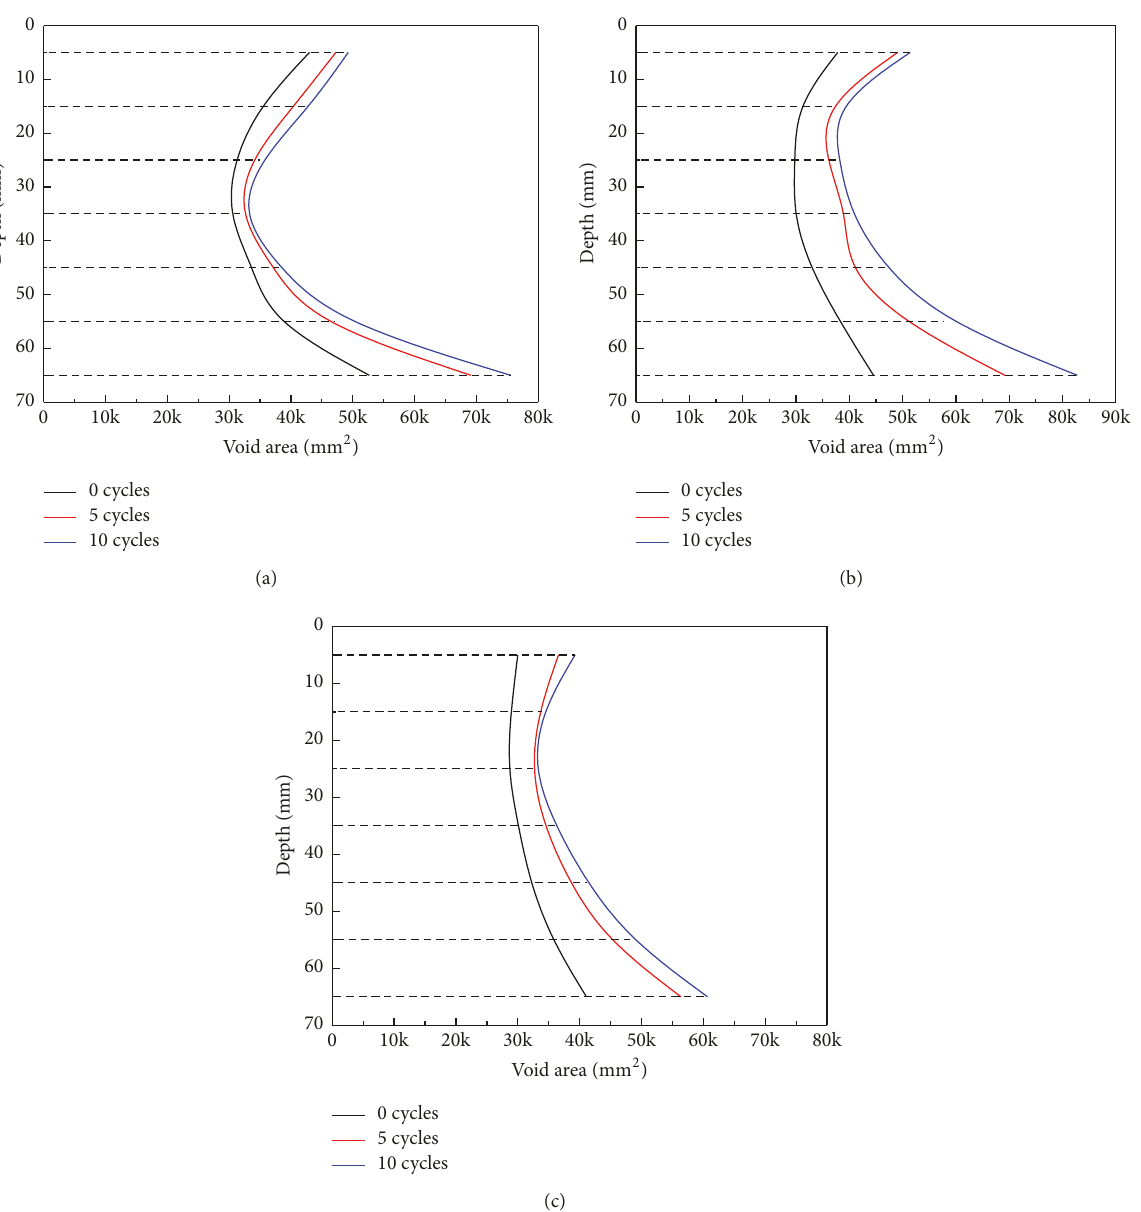
Figure 7: Distribution of the void areas of different samples after 28 d of curing: (a) cement content = 4.0%; (b) cement content = 4.5%; (c) cement content =